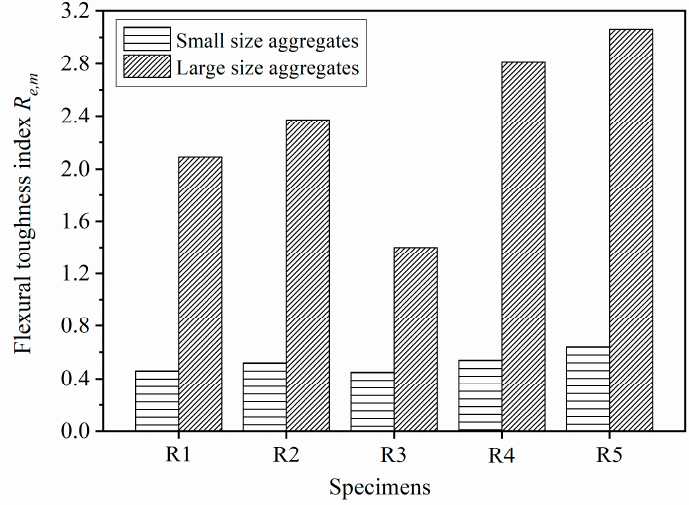
Figure 16. Toughness index R e , m of the geogrid-reinforced beam.